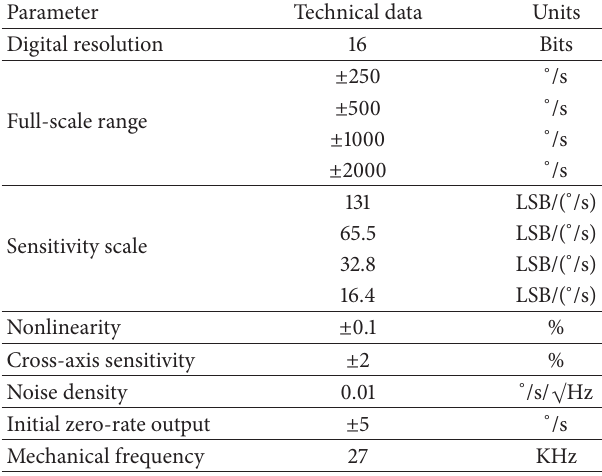
(vertical to span direction) are used to identify the natural frequency of the bridge